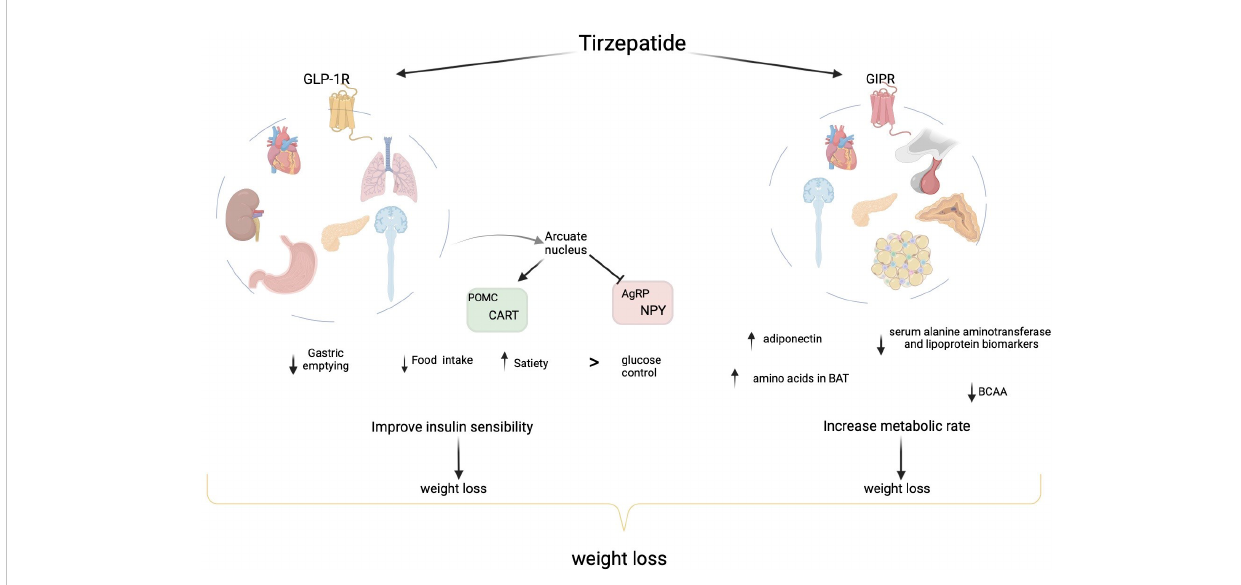
FIGURE 2 Physiological mechanism of incretins and a dual GIP/GLP-1 receptor agonist on weight loss. GLP-1, synthesized in the intestine, binds to its receptor, which is expressed in b -cells, a -cells, the kidneys, the lungs, gastric mucosa, the heart, and the brain. GLP-1-RA improves glucose control and stimulates signi fi cant weight loss by reducing gastric emptying, stimulating satiety, and decreasing food intake, and it acts on peripheral and central receptors in the gut and brain. GLP-1-RA reaches the arcuate nucleus, where it stimulates neurons that regulate appetite and express proopiomelanocortin (POMC) and cocaine- and amphetamine-regulated transcripts (CART), and it indirectly inhibits neurotransmission in neurons expressing neuropeptide Y (NPY) and agouti-related peptide (AgRP). GIP, secreted by K cells of the small intestine, binds to its receptor (GIPR) in the pancreas, adipose tissue (both white and brown adipose tissue), heart, pituitary, adrenal cortex, and some areas of the central nervous system (CNS). In a pharmacological context, GIP induces weight loss by stimulating satiety in the hypothalamus. Tirzepatide, which simultaneously stimulates GIP and GLP-1 receptors, increases general insulin sensitivity, improves glycemic control, and increases weight loss compared to GLP-1-RAs. Tirzepatide increases adiponectin and decreases serum alanine aminotransferase and lipoprotein biomarkers. Moreover, branched-chain amino acids (BCAAs) and their catabolic products are signi fi cantly reduced by tirzepatide. Tirzepatide imitates the effect of cold exposure on the amino acid pro fi le in BAT, resulting in improved insulin sensitization, increased metabolic rate, and increased weight